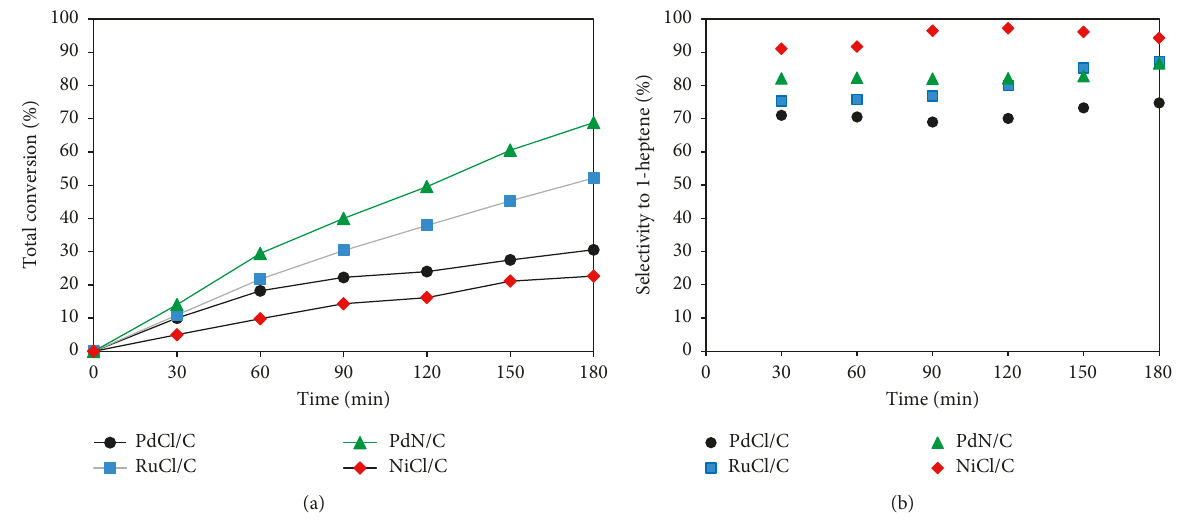
Figure 8: Total conversion (a) and selectivity to 1-heptene (b) versus time (min) for PdN/C, PdCl/C, RuCl/C, and NiCl/C catalysts pretreated in H 2 at